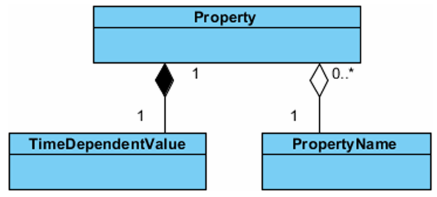
Fig. 6. UML diagram of feature property in